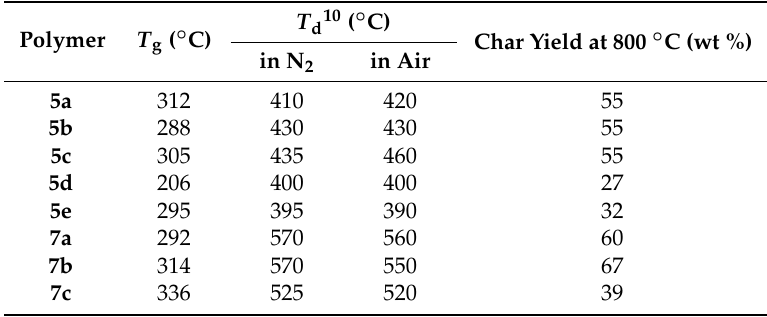
Table 2. Thermal properties of the polymers.